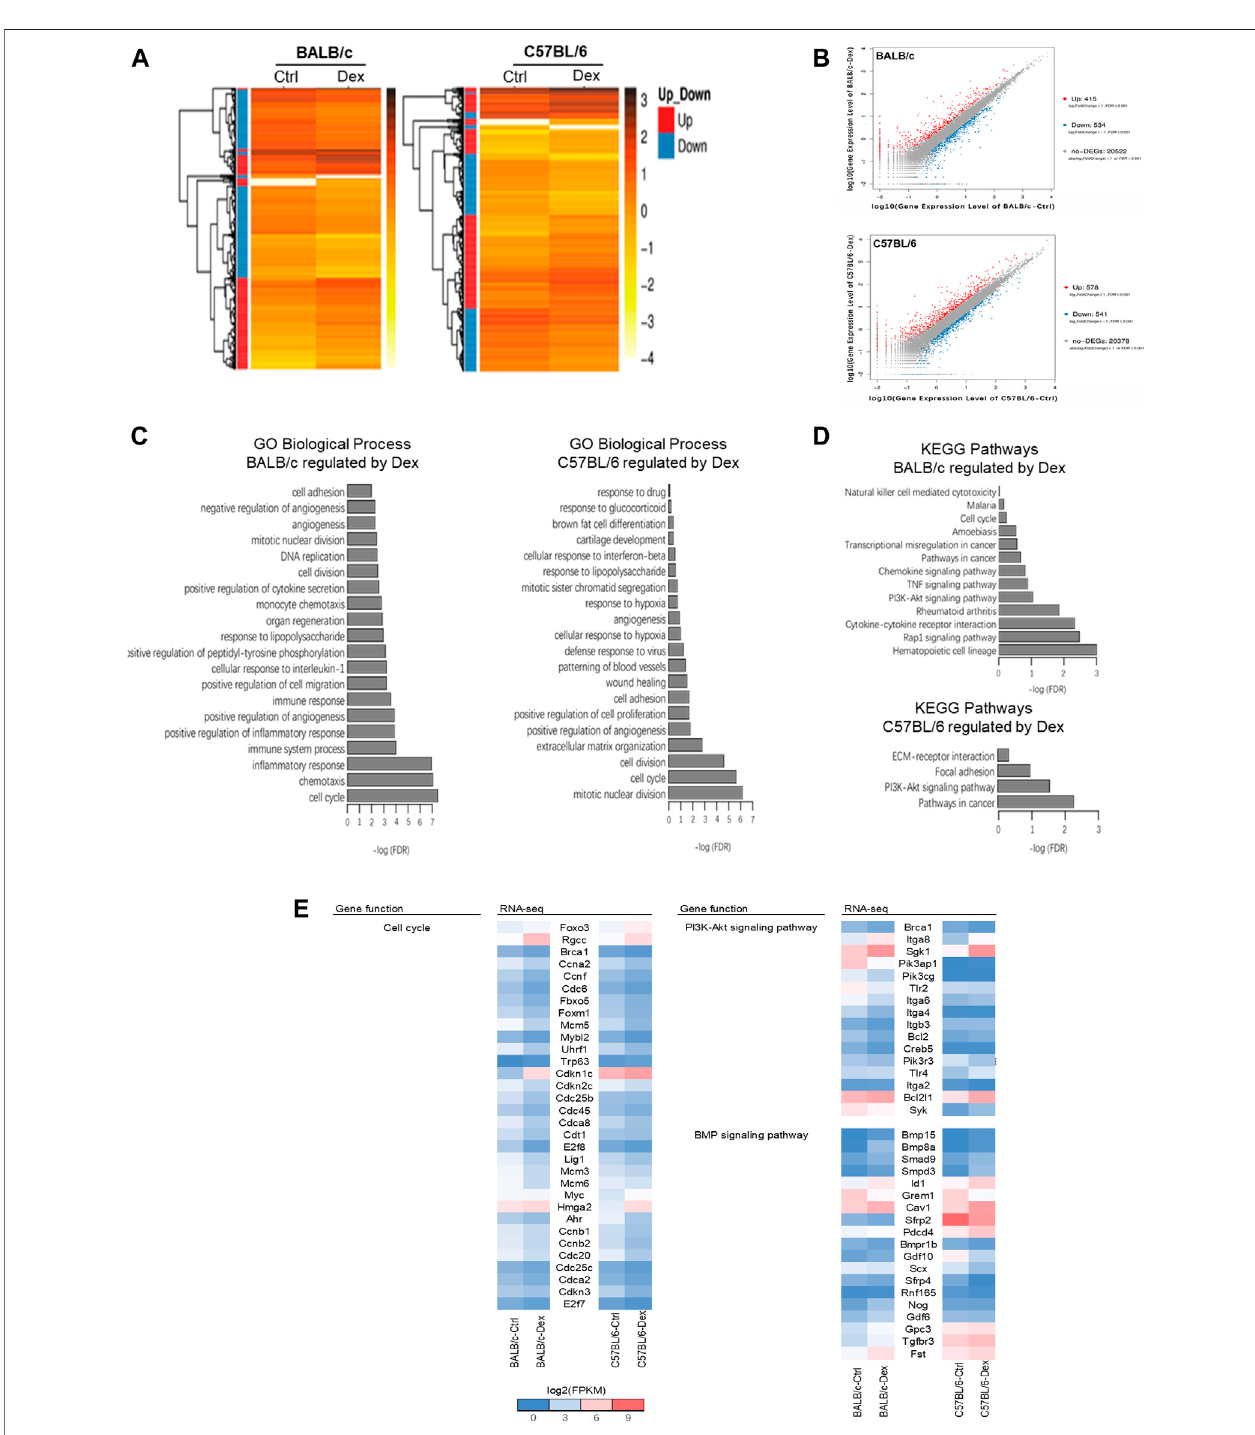
FIGURE 4 | Transcriptomic analysis of genes regulated by dexamethasone in mouse osteoblasts of two strains. (A) Heatmap of DEGs in Dex-treated mouse osteoblasts. (B) Scatterplotoflog10FPKMvaluesofgenesexpressedinDex-treatedosteoblastsversusuntreated osteoblasts.Thereddotsandbluedotsidentifythat are differentially expressed at log2FoldChange ≥ with FDR ≤ 0.001 between untreated and Dex-treated MSCs (red dots represent the up-regulated genes, blue dots represent the down-regulated genes, gray dots represent the non-DEGs). (C) Top 20 GO Biological process terms of Gene ontology analysis of Dex-regulated genes. (D) KEGG pathway analysis enriched signaling pathways altered by Dex. (E) Gene expression shown in log2(FPKM+1) of genes relevant to PI3K-Akt and BMP signaling pathways for untreated and Dex-treated osteoblasts of BALB/c and C57BL/6.